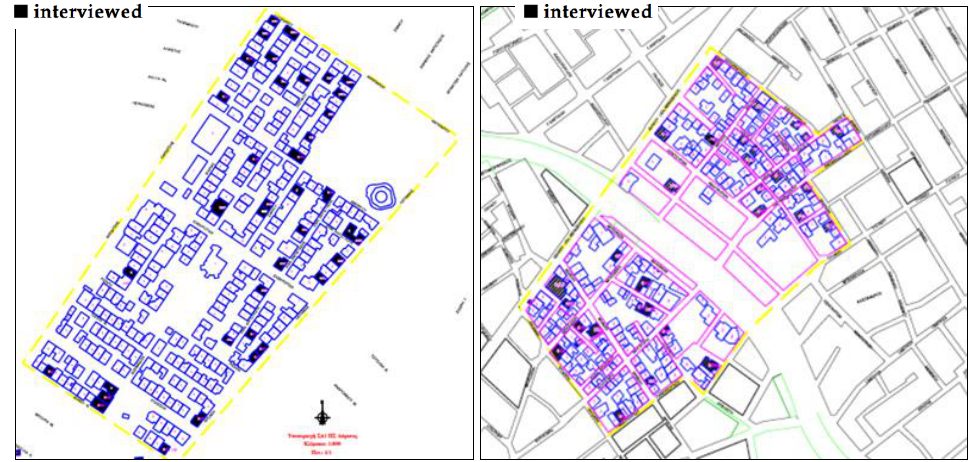
Figure 8. Location of the buildings in which interviews were conducted (black mark). On the left in Larissa, the Erchrechontida district, on the right, the Iolkou district in Volos.